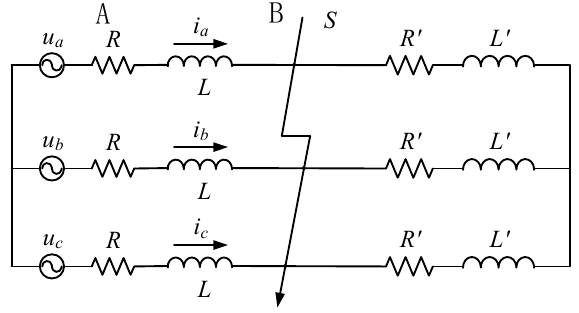
Figure 6. Three-phase short circuit.